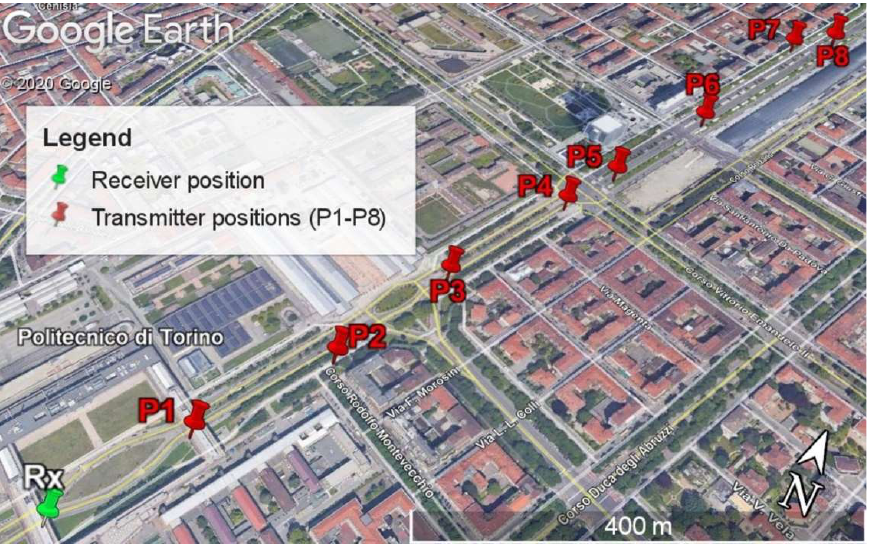
Figure 4. System Setup 1 used to determine the transmission ranges reached by the radioprobe system in an urban environment displayed on a map. Transmitters (P1 to P8) and receiver (Rx) position with relative distance indications. Google Earth view. Table 2. Results of the point-to-point measurements in urban environment (Setup 1).